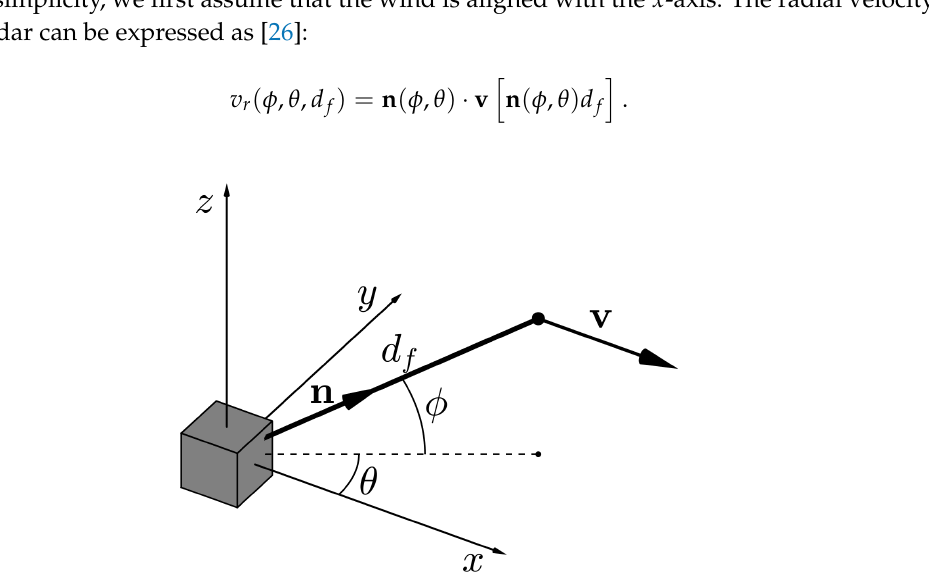
Figure 1. Sketch of a scanning lidar measuring the wind v at a distance d f with a beam in the direction of the unit vector n = n ( θ , φ )